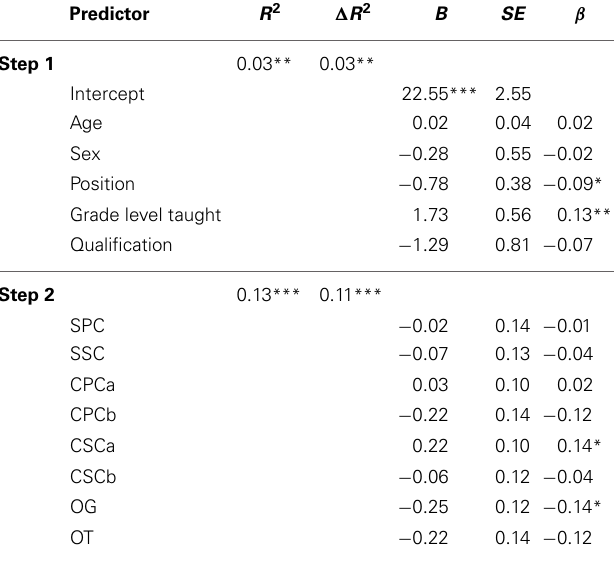
Table 5 | Summary of hierarchical multiple regression analysis predicting negative affect from demographic variables and control